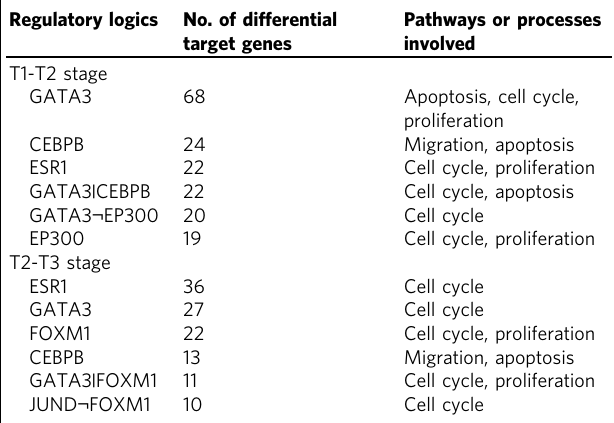
Table 1 Top-ranked TF regulatory logics identi fi ed in breast cancer Regulatory logics No. of differential target